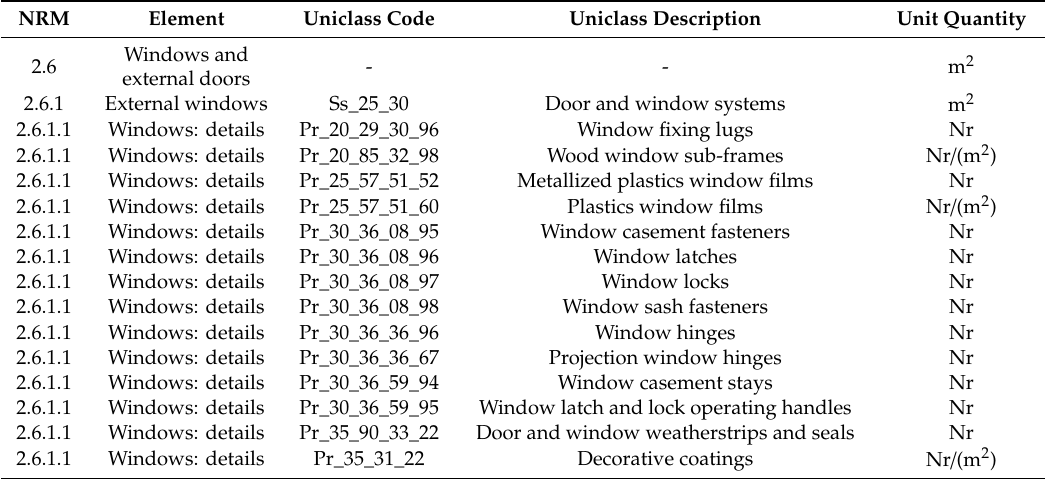
Table 2. Sub-elemental breakdown for extraction of